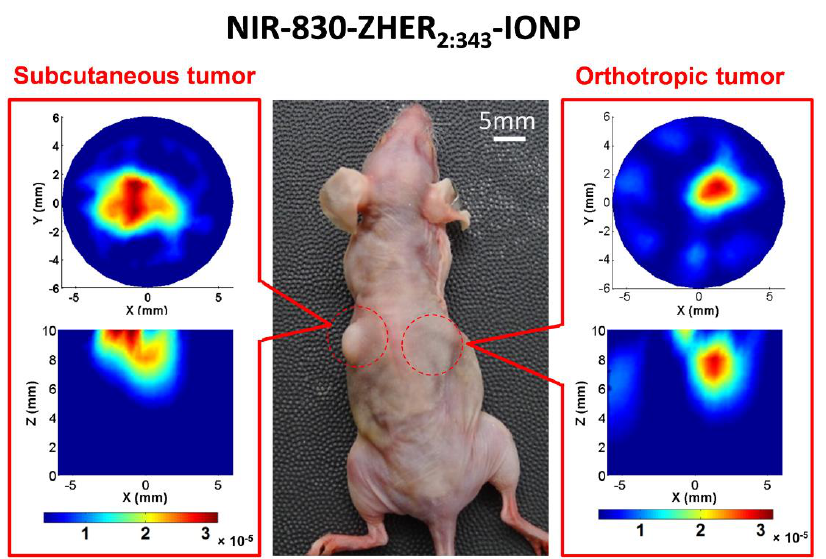
Figure 5. FMT images of a tumor-bearing mouse using NIR-830-ZHER2:343-IONP: photograph of the mouse (middle), transverse and sagittal FMT slices of subcutaneous tumor (left), (right) transverse and sagittal FMT slices of orthotropic tumor